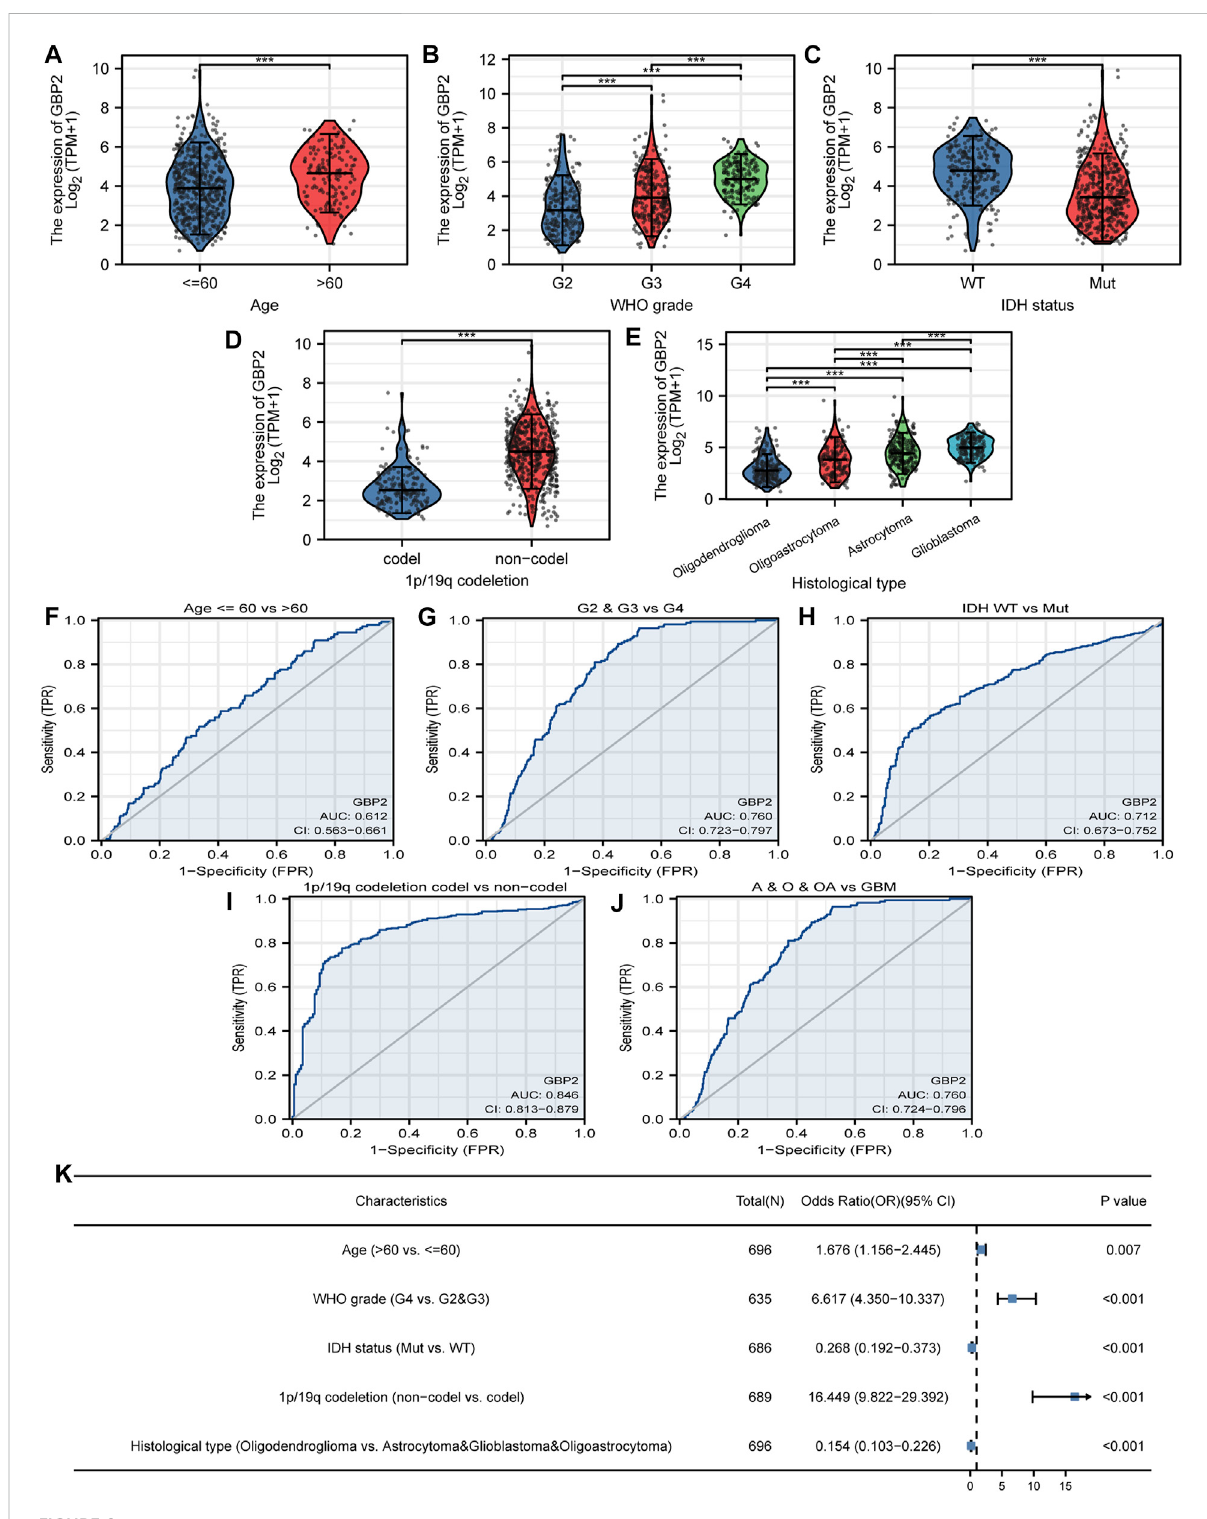
FIGURE 2 GBP2-related clinicopathological features in glioma. GBP2 expression in glioma clinically relevant features including age (A) , WHO grade (B) , IDH status (C) , 1p/19q cedeletion (D) , histological type (E) . ROC curves show the diagnostic ef fi cacy of GBP2 expression for age (F) , WHO grade (G) , IDH status (H) , 1p/19q cedeletion (I) , histological type (J) . (K) Logistic regression analysis of clinicopathological parameters and GBP2 expression. *** p <